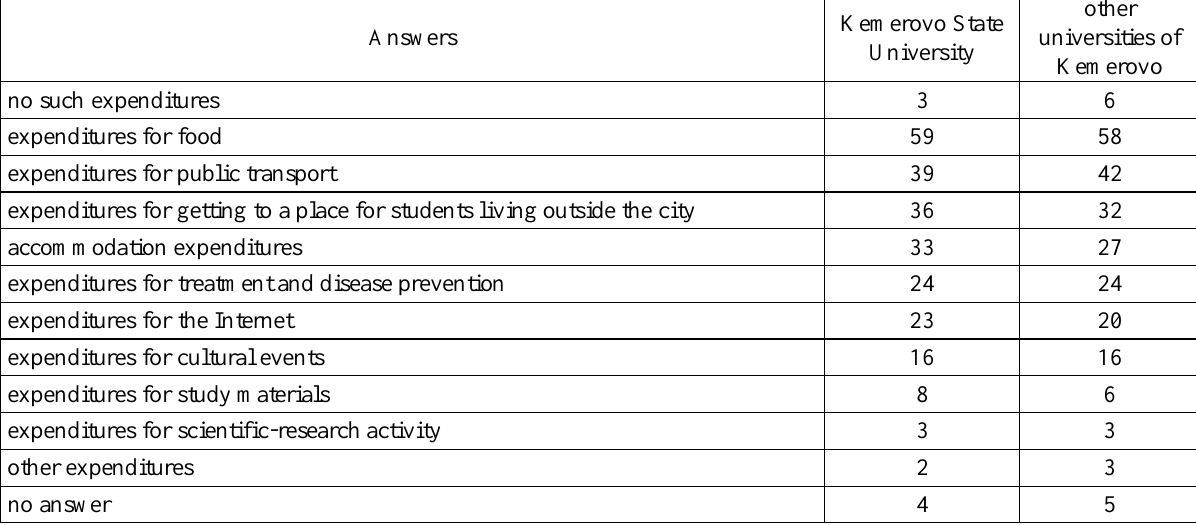
Table 1. Material expenditures, most relevant for financial support (% from the number of